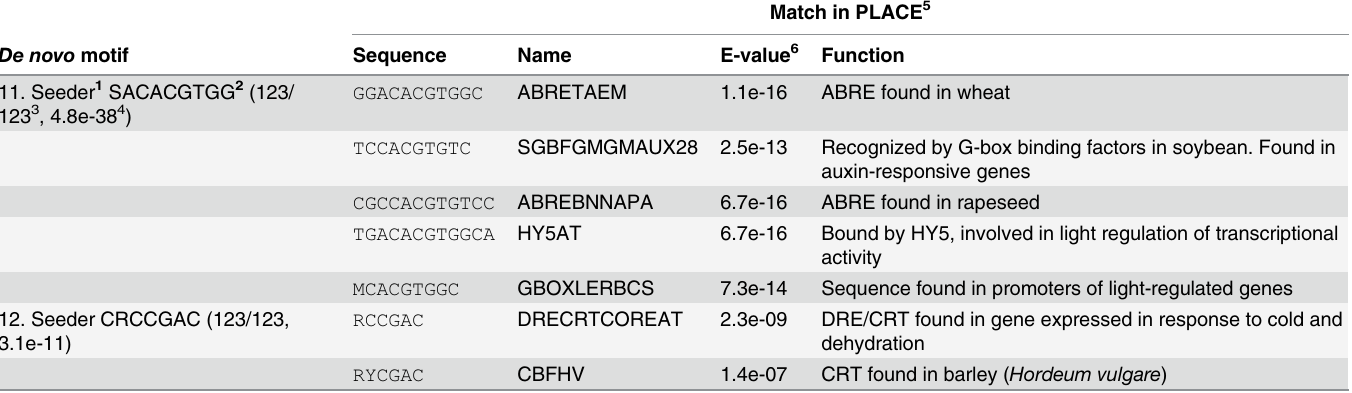
Table 5. Selected de novo motifs found in Y n SK n dehydrin promoters and their putative function identified through PLACE database.